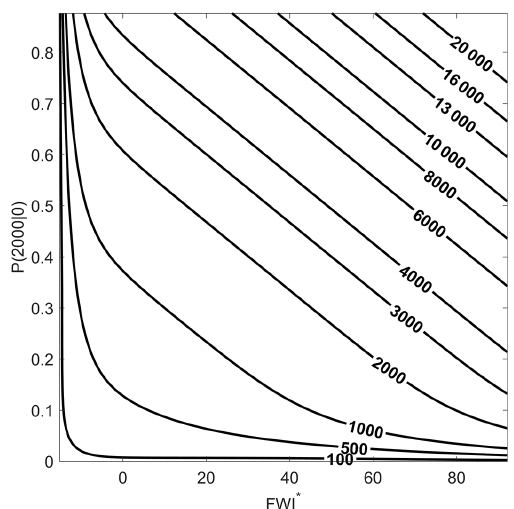
Figure 11. Dependence of scale parameter σ of the GP distribu- tion on covariates FWI ∗ and P( 2000 | 0 ) as modelled by the neural